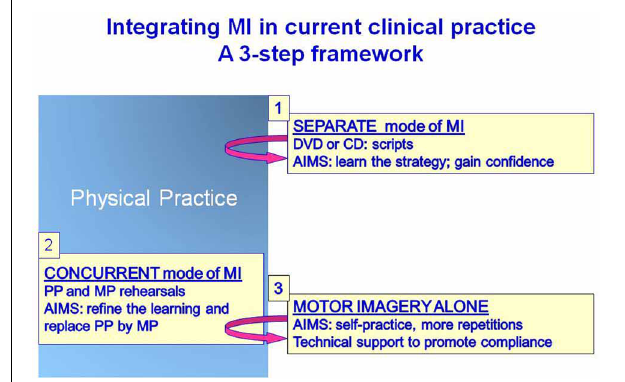
FIGURE 5 | Schematic representation of a framework for integrating MI training in current clinical